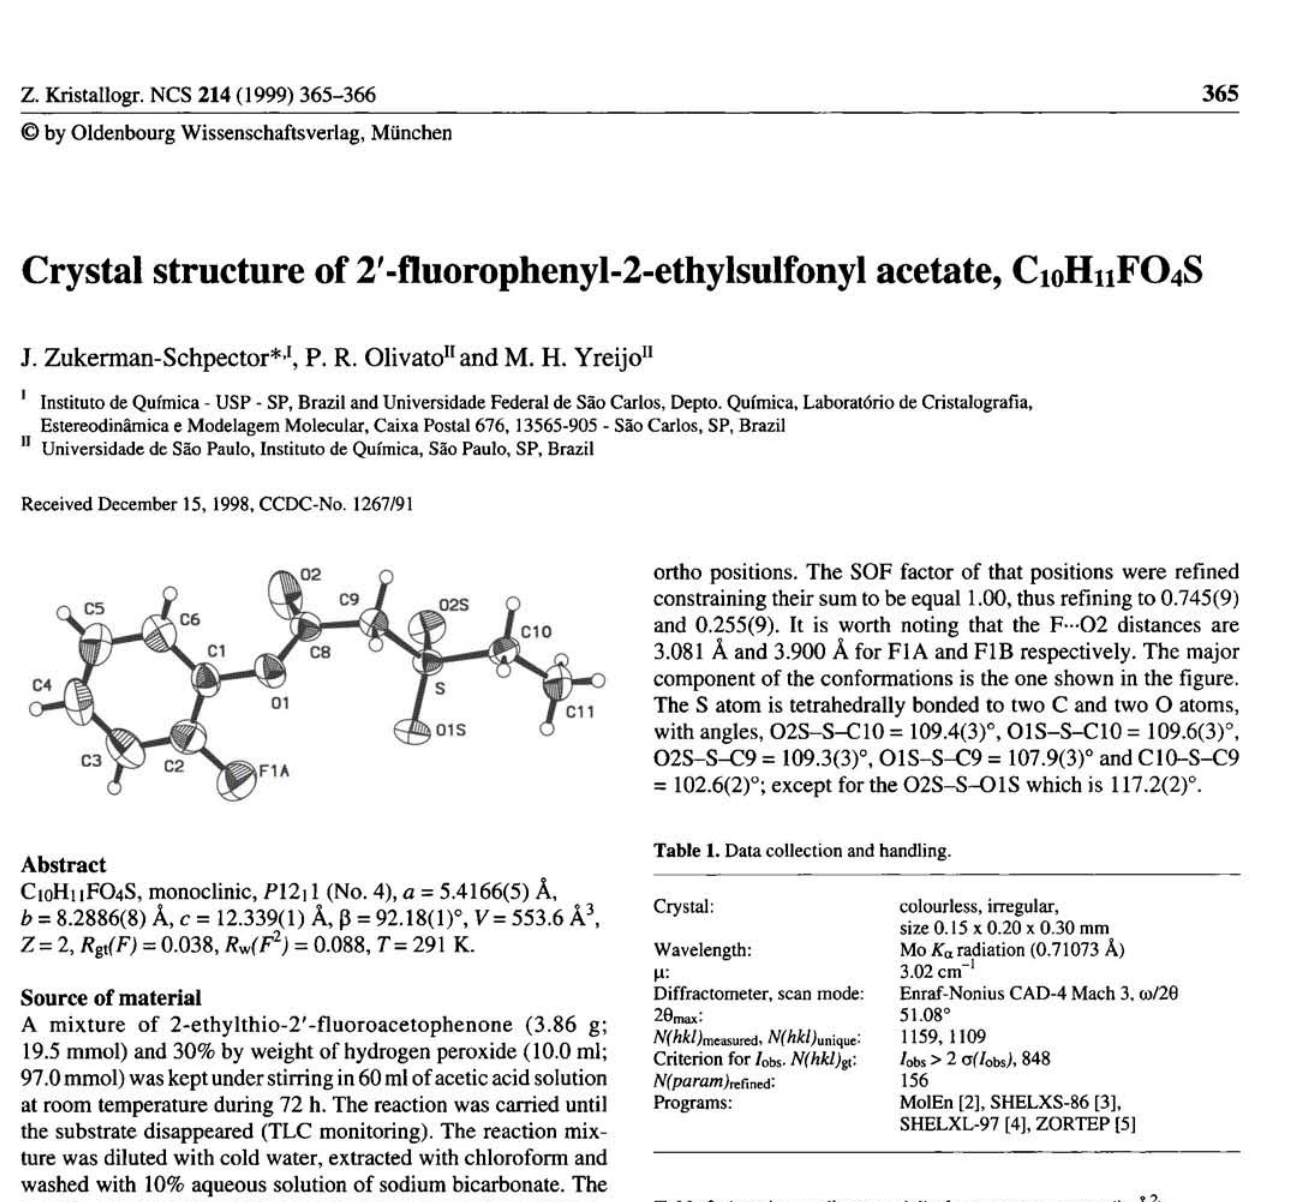
Table 2. Atomic coordinates and displacement parameters (in Â 2